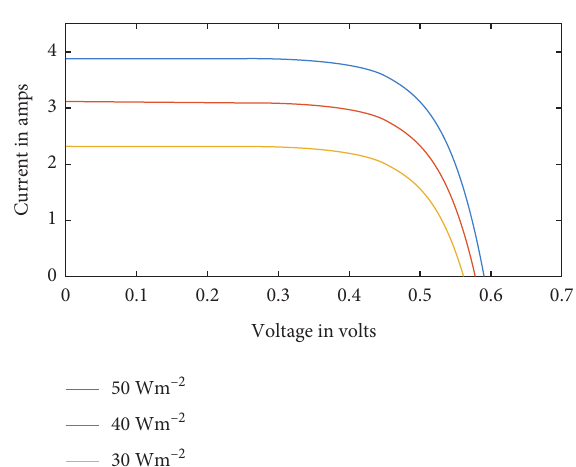
Figure 4: Simulated I-V plot of varying Irradiance of a solar cell.